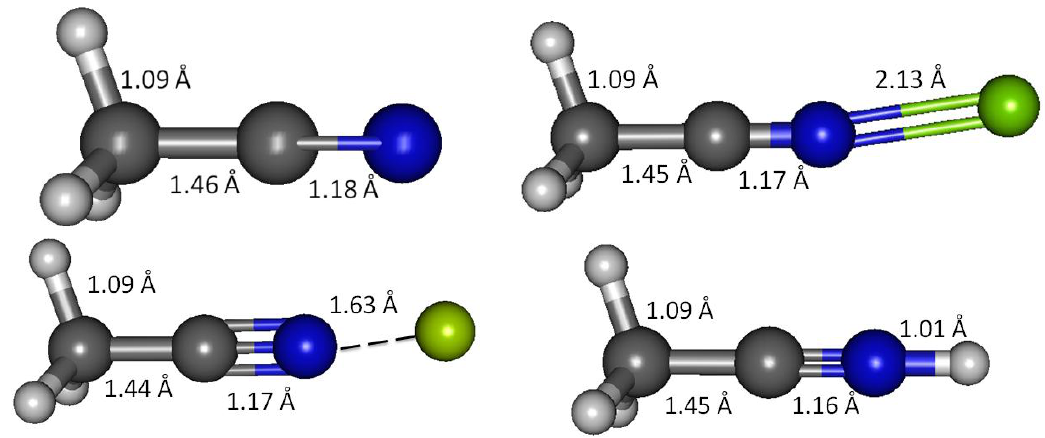
Figure 1. G3 optimized geometries of acetonitrile and its complexes with Be(II), Mg(II)